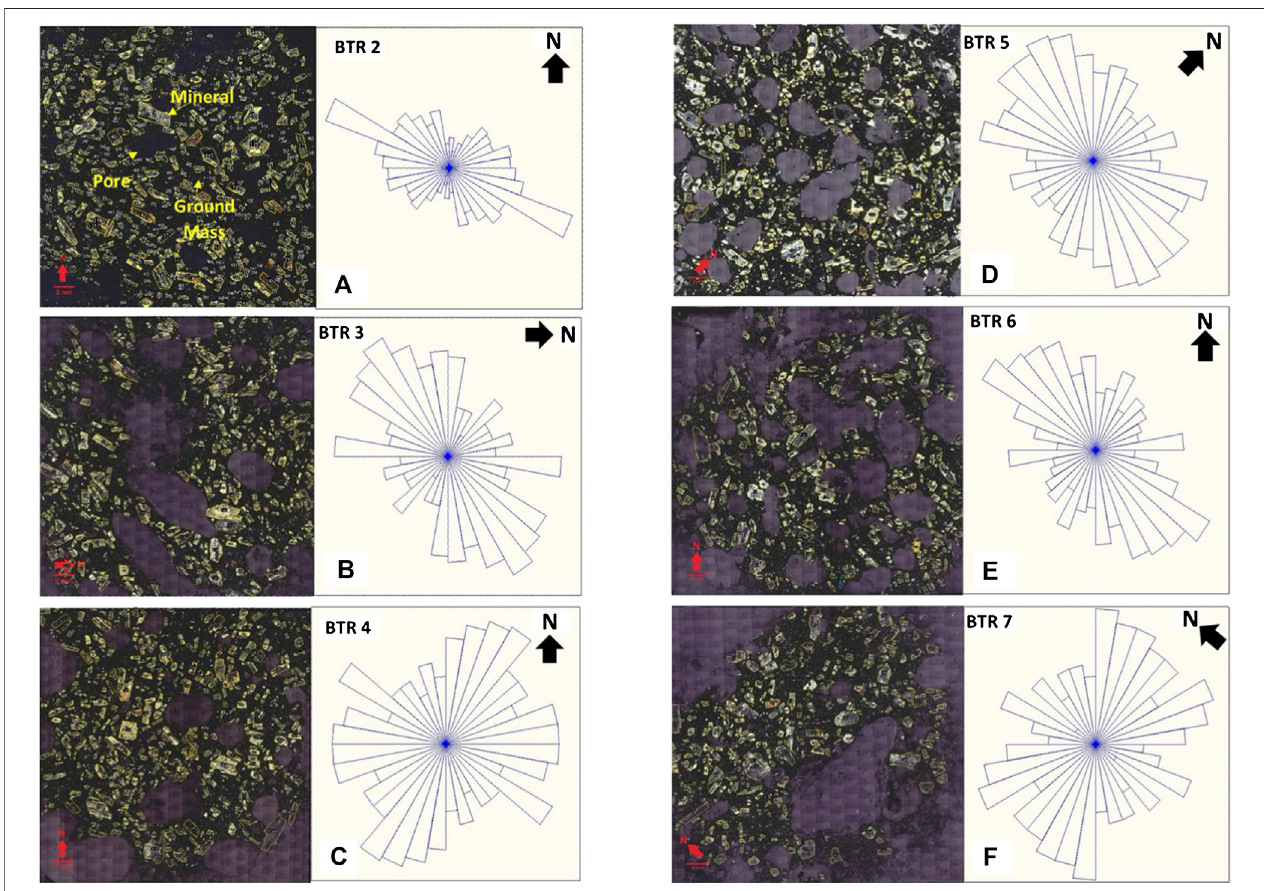
FIGURE 2 | Mineral orientation based on petrographic analyses on thin sections for representative specimens of BTR2 (A) , BTR3 (B) , BTR4 (C) , BTR5 (D) , BTR6 (E) , and BTR7 (F) . Notes in BTR2 (A) show typical pore, groundmass and mineral (i.e., plagioclase). Red arrows indicate north direction.